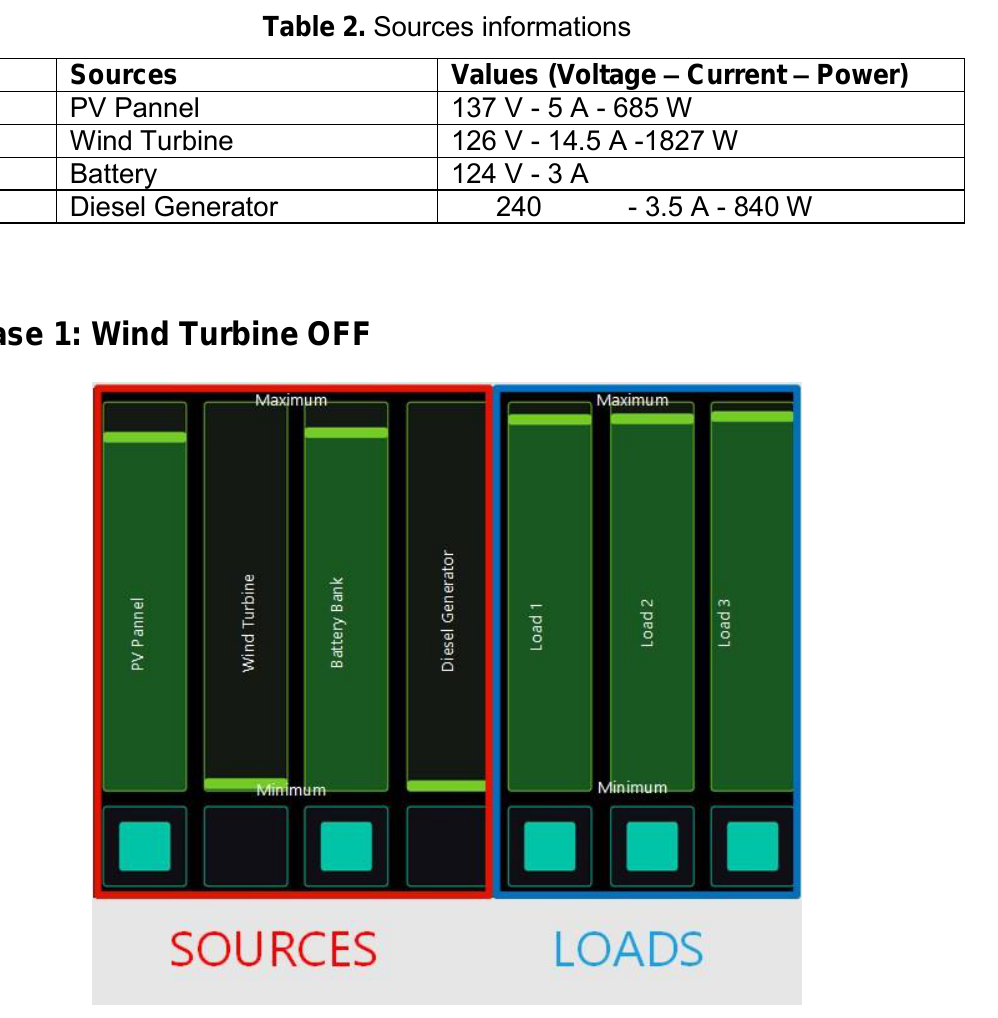
Figure 7. Monitoring Screen with PV panel Source and battery bank